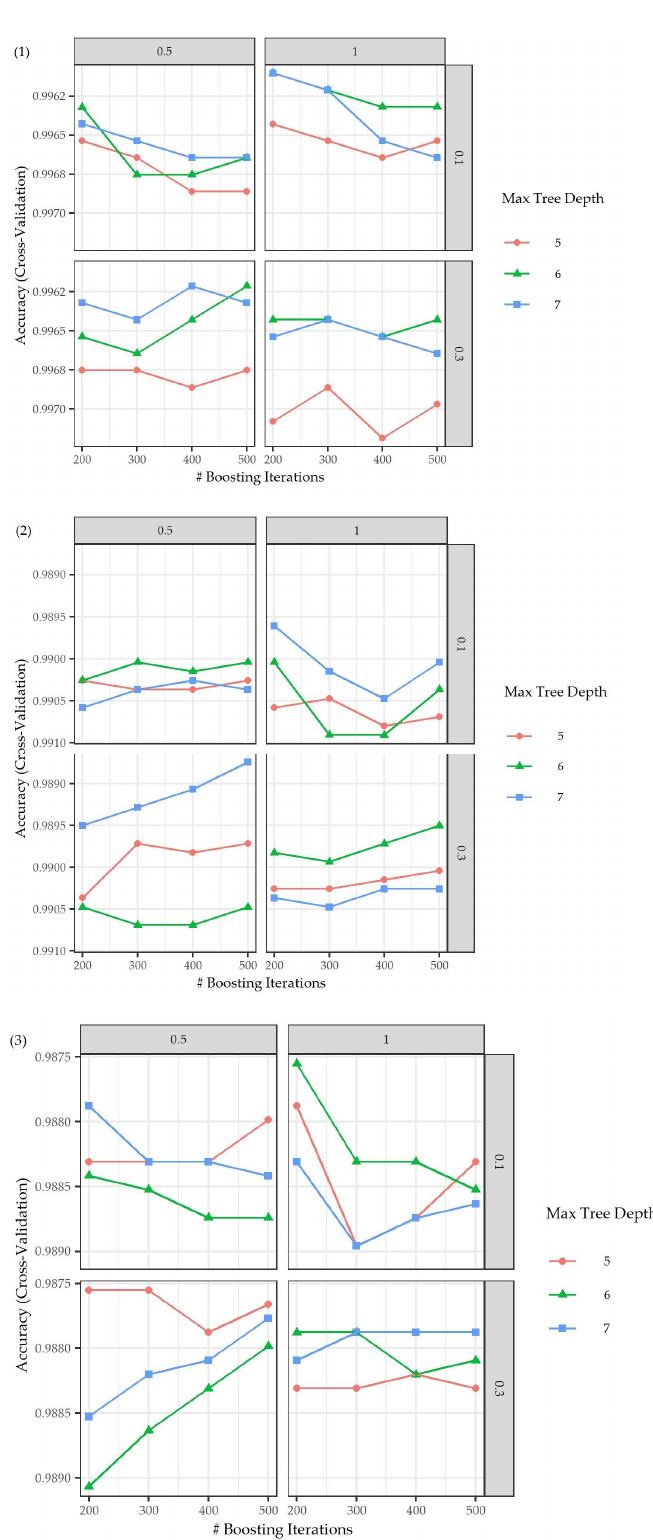
Figure A4. The optimal XGBoost models were selected using the maximum accuracy obtained from fivefold cross-validation. (1) XGBoost (all variables), (2) XGBoost (important variables), and (3) XGBoost (important and uncorrelated variables). Note: The upper axis and the right axis represent the parameters subsample and eta , respectively.